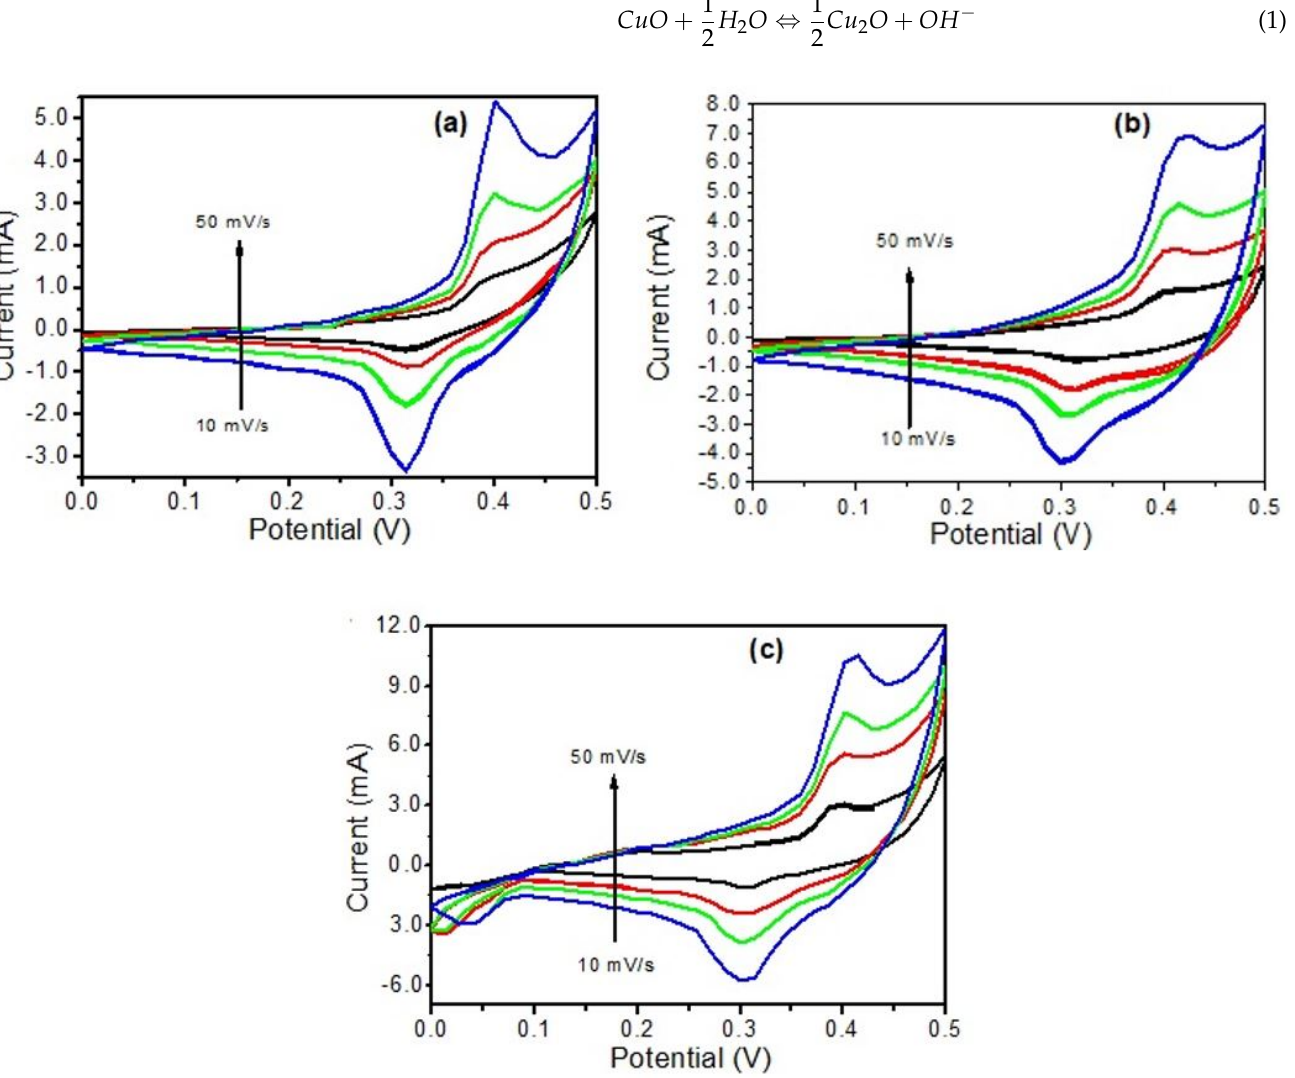
Figure 7. CV curve of ( a ) pure CuO nanosheets, ( b ) rGO@CuO and ( c ) Ag-rGO@CuO nanocomposites at different scan rates.